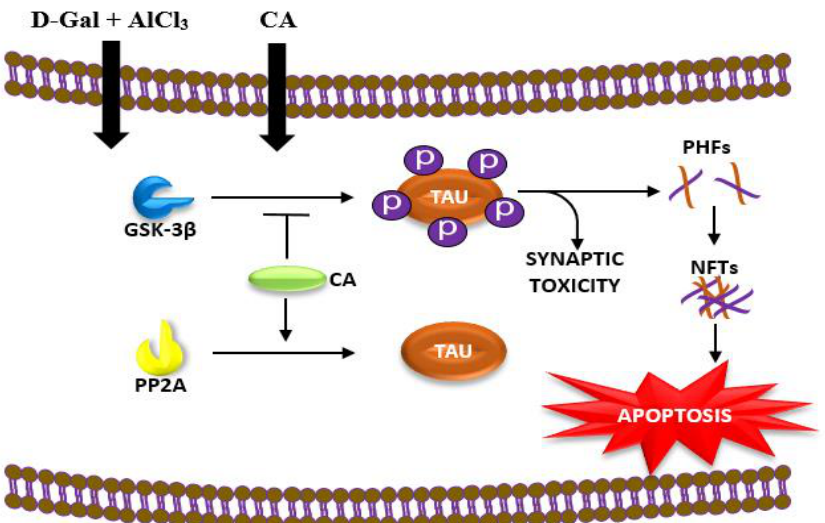
Figure 5. Proposed mechanism of protective e ff ects of CA against d -gal and AlCl 3 induced neurotoxicity in rats, via the inhibition of GSK-3 β and enhancing the expression of PP2A in the hippocampus of the rats. d -gal / AlCl 3 enhances phosphorylation of tau protein, which leads to paired helical forms (PHFs) formation and subsequently aggregates to form neurofibrillary tangles (NFTs), eventually leading to the death of the neuron. CA blocks the action of GSK-3 β and enhances the activities of PP2A.